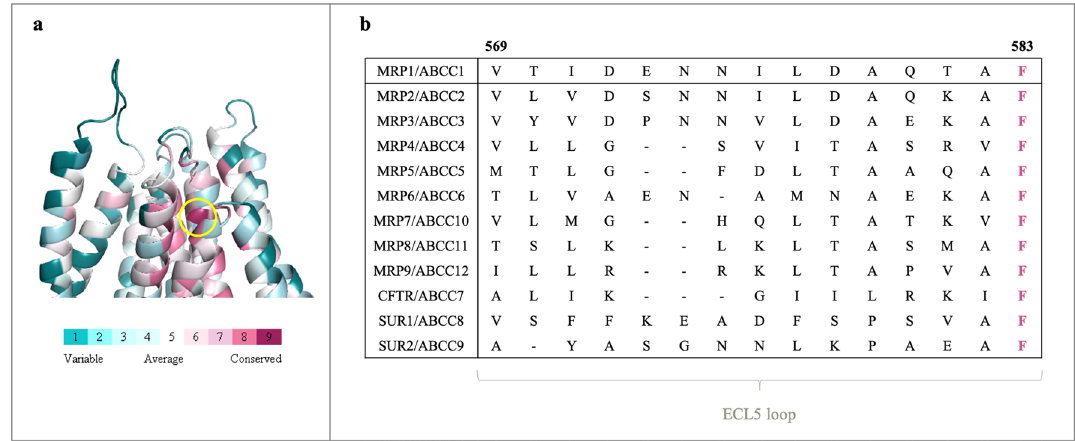
Figure 3. Conservation analysis of F583. (a) Cartoon representation of the extracellular part of the protein, colored in cyan to purple scale, from the most variable residue to the most conserved residue, respectively. F583 is colored by dark purple (score: 9), presenting the highest conservation score, and is indicated by a yellow circle. (b) Sequence alignment of the ECL5 loop of the human MRP1 and its homologs from the ABCC subfamily, illustrating high conservation of F583 in comparison with the other